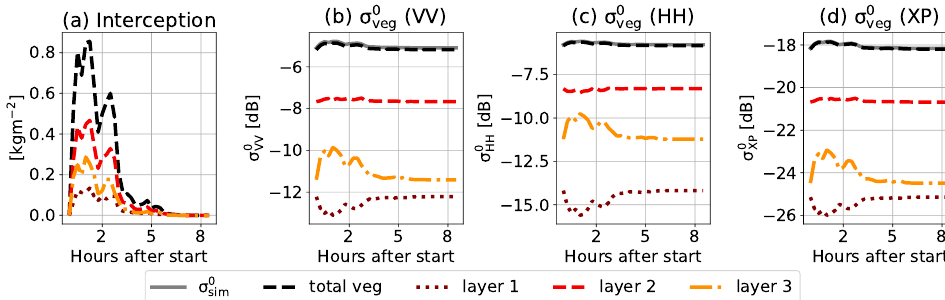
Figure 10. Averaged heavy rainfall interception estimates from 2018 separated by layer ( a ); and the corresponding variations in the layer contributions to total vegetation scattering ( σ 0 veg ), simulated by the water cloud model and separated by VV ( b ); HH ( c ; and cross-polarization ( d ).